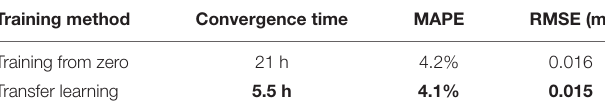
TABLE 4 | Transfer learning with convergence speed and performance